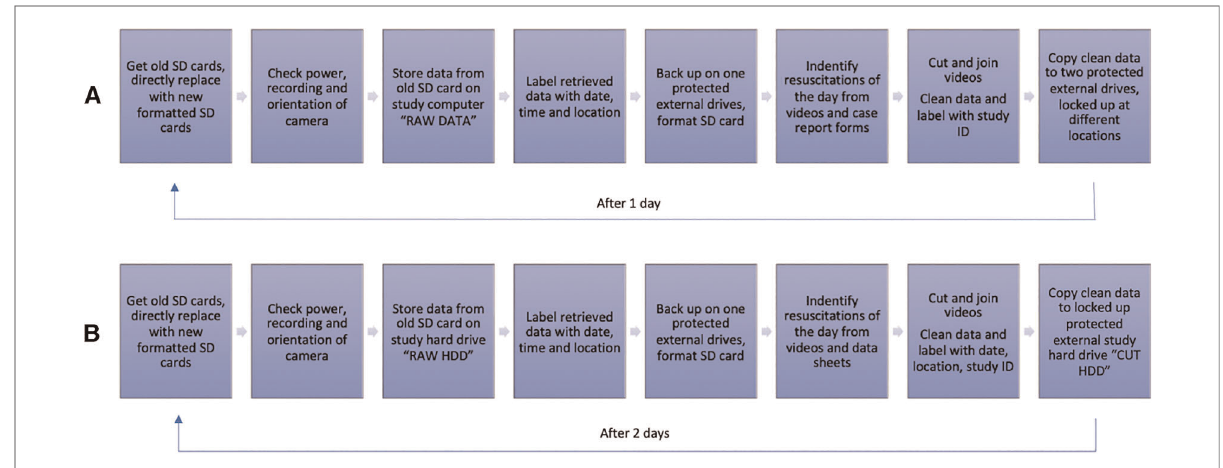
FIGURE 1 Video camera process for Uganda ( A ) and Vietnam ( B ) from the insertion of SD card into camera to video recording and fi nal cut ready for analysis.